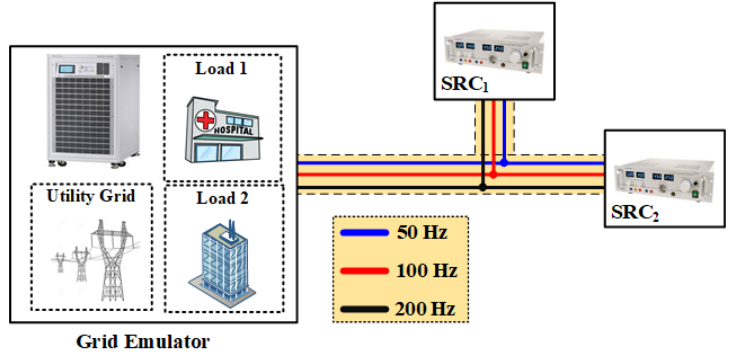
Figure 8. Considered microgrid for experimental study.